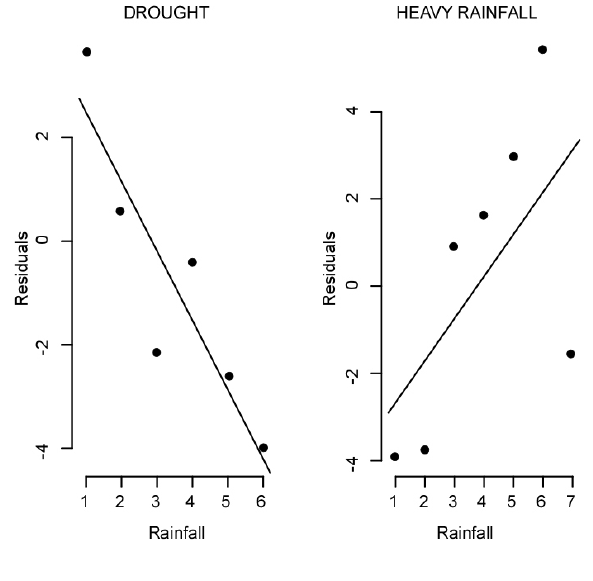
climatic accidents, as a function of observed